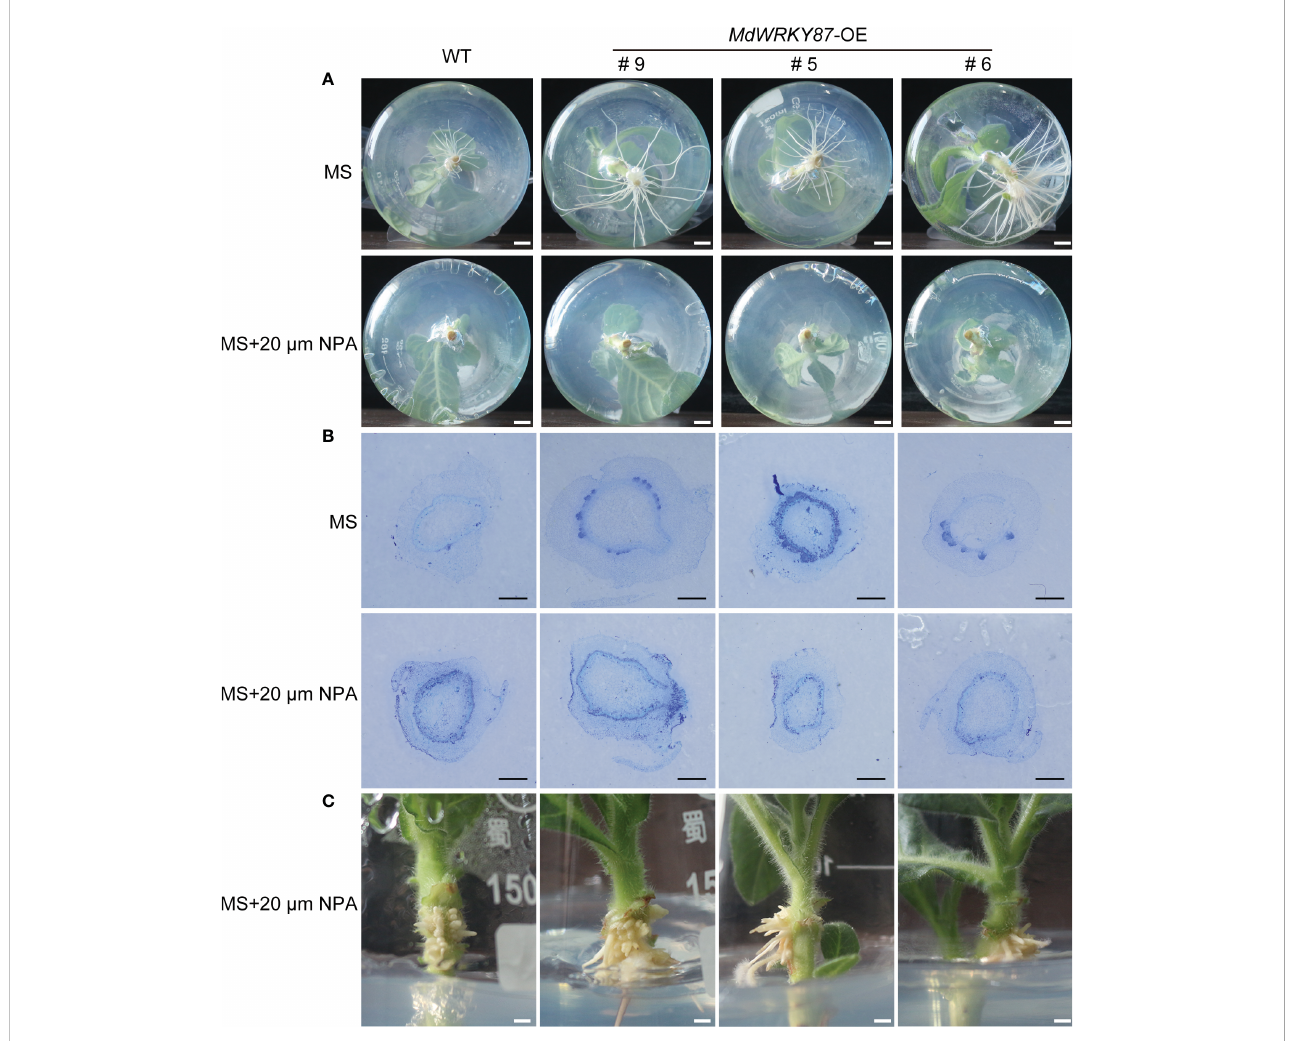
FIGURE 5 Effects of NPA on adventitious root formation in transgenic tobacco and wild-type plants. (A) Phenotypes of 10-day-old plants (WT, and MdWRKY87- OE lines) grown on MS medium with 20 µM NPA. (B) Cross-sections of stem bases at 5 days after transplanting during adventitious root formation in WT and MdWRKY87- OE lines. Sections were stained by toluidine blue. Scale bars = 500 µm. (C) Stem air root of wild type and MdWRKY87- OE lines at 15 days after transplant to MS medium with 20 µM